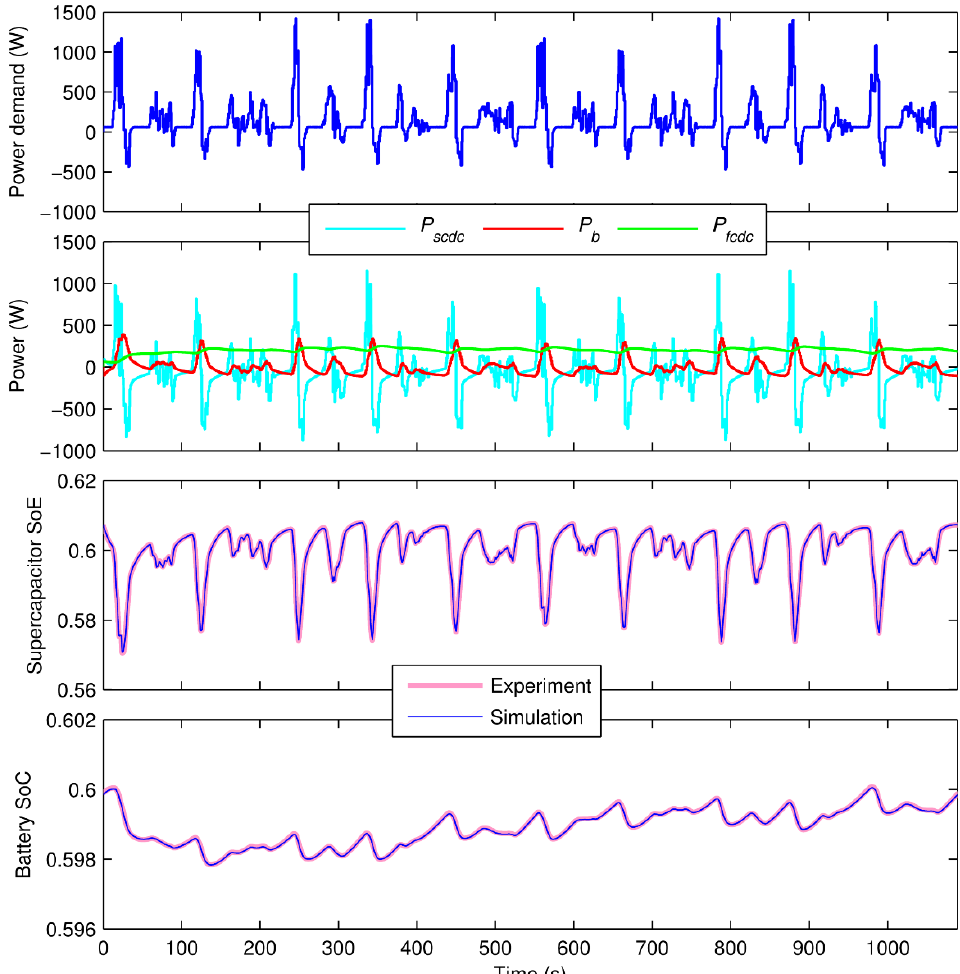
Figure 13. Experimental evaluation of the power management strategy S1 over